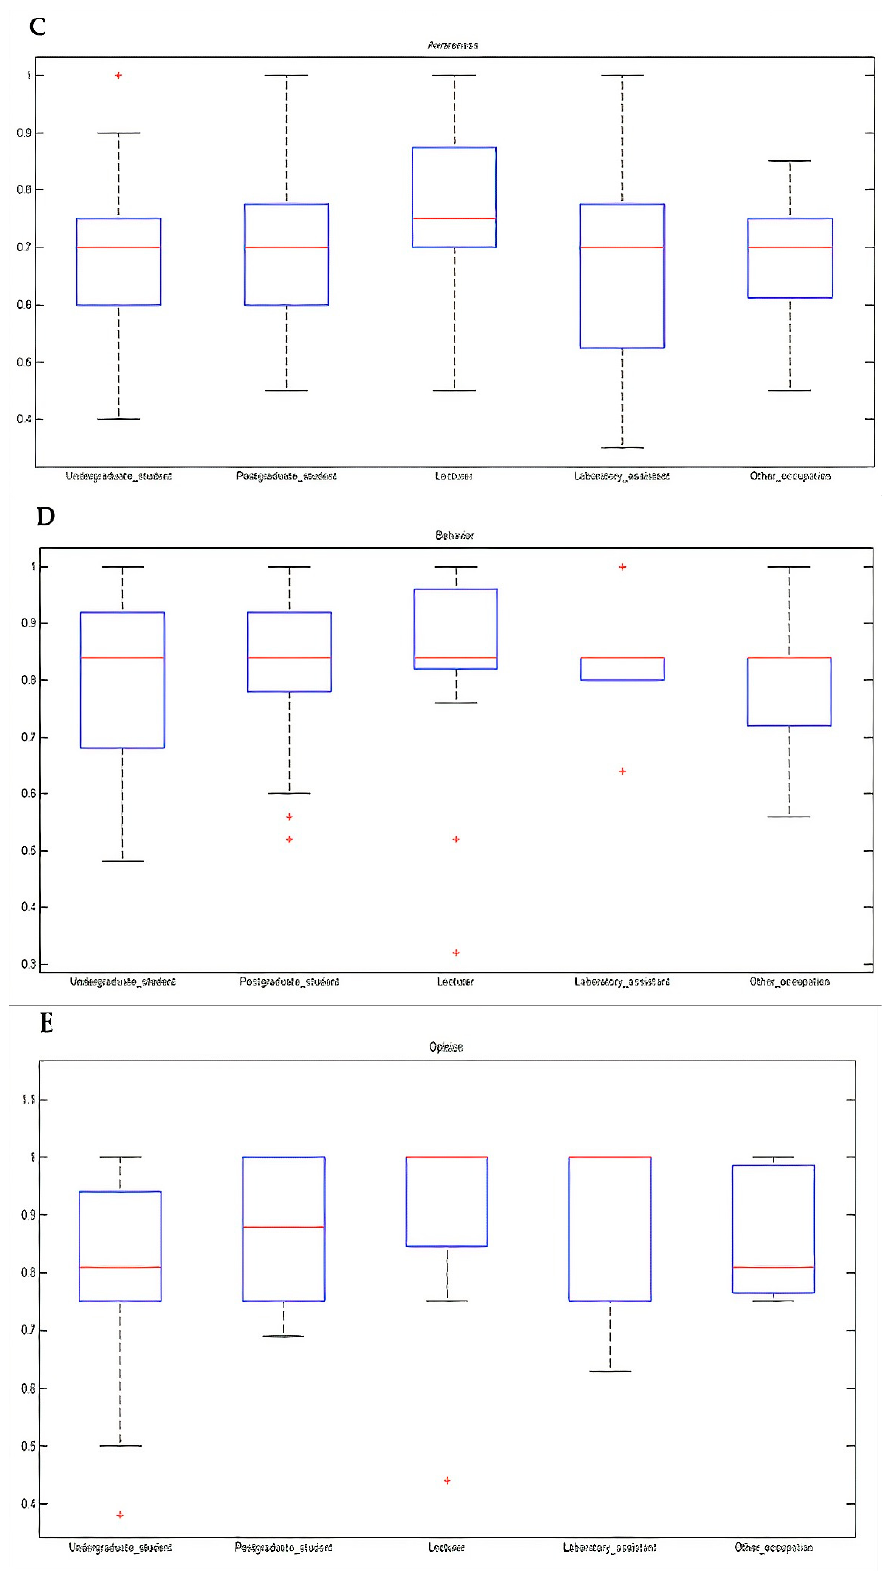
Figure 4. Boxplot of variables ( A ): “Knowledge”, ( B ): “Awareness”, ( C ): “Practice”, ( D ): “Behavior”, and ( E ):